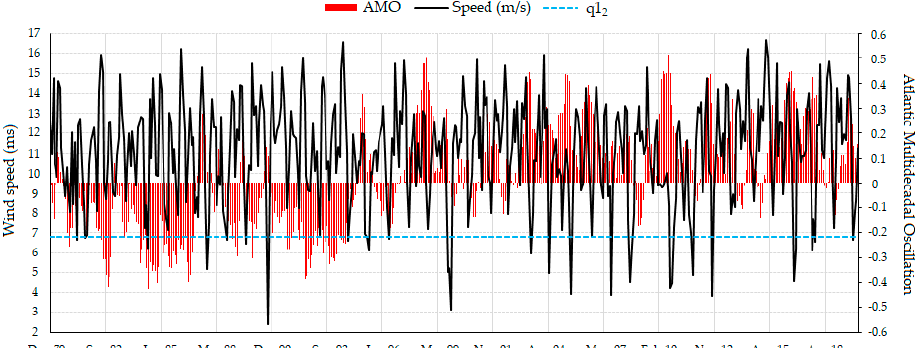
Figure 6. Wind speed series at 925 hPa, AMO index and q1 2 threshold.